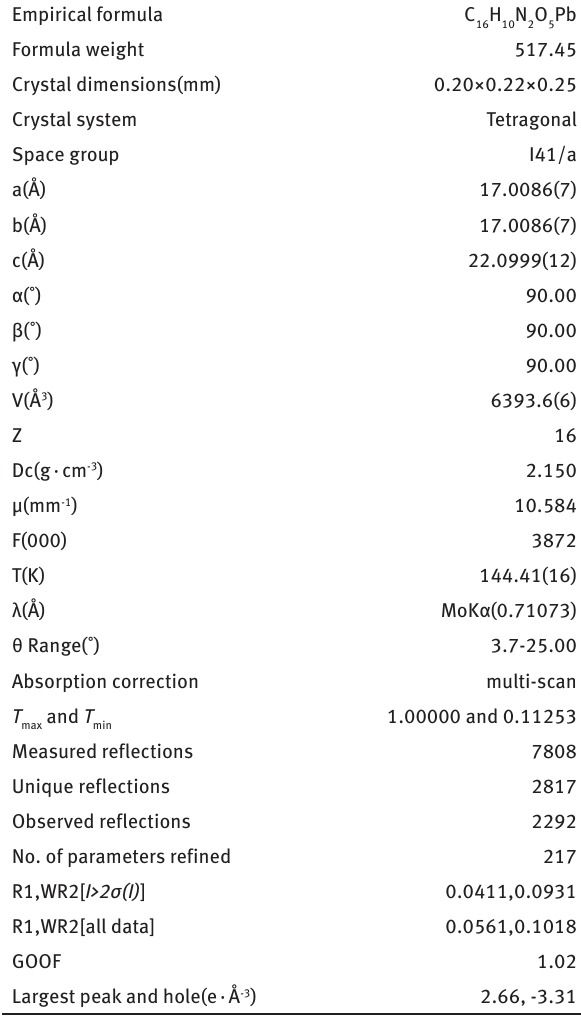
Table 2: Crystal data and Refinement Parameters. Empirical